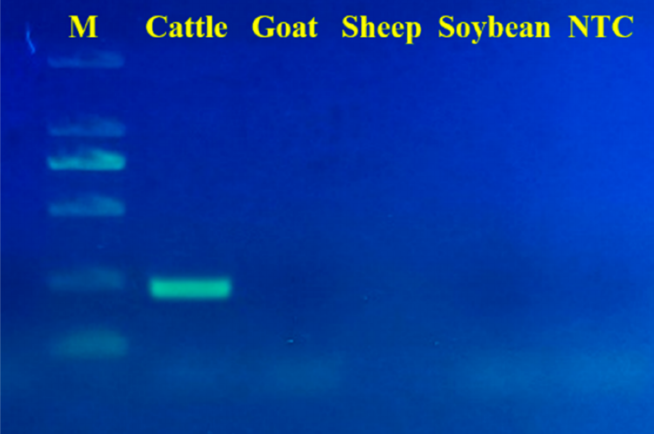
Figure 1. Amplification result based on the best RPA primers for cattle genomic DNA. NTC: nontarget